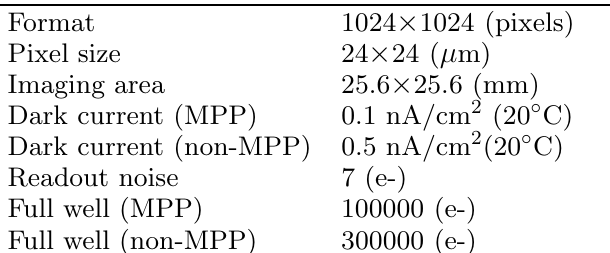
Fig. 1. The Tromsø CCD photometer on the Mol˙etai 1.65 m telescope. Table 1. SiTe TK1024 device